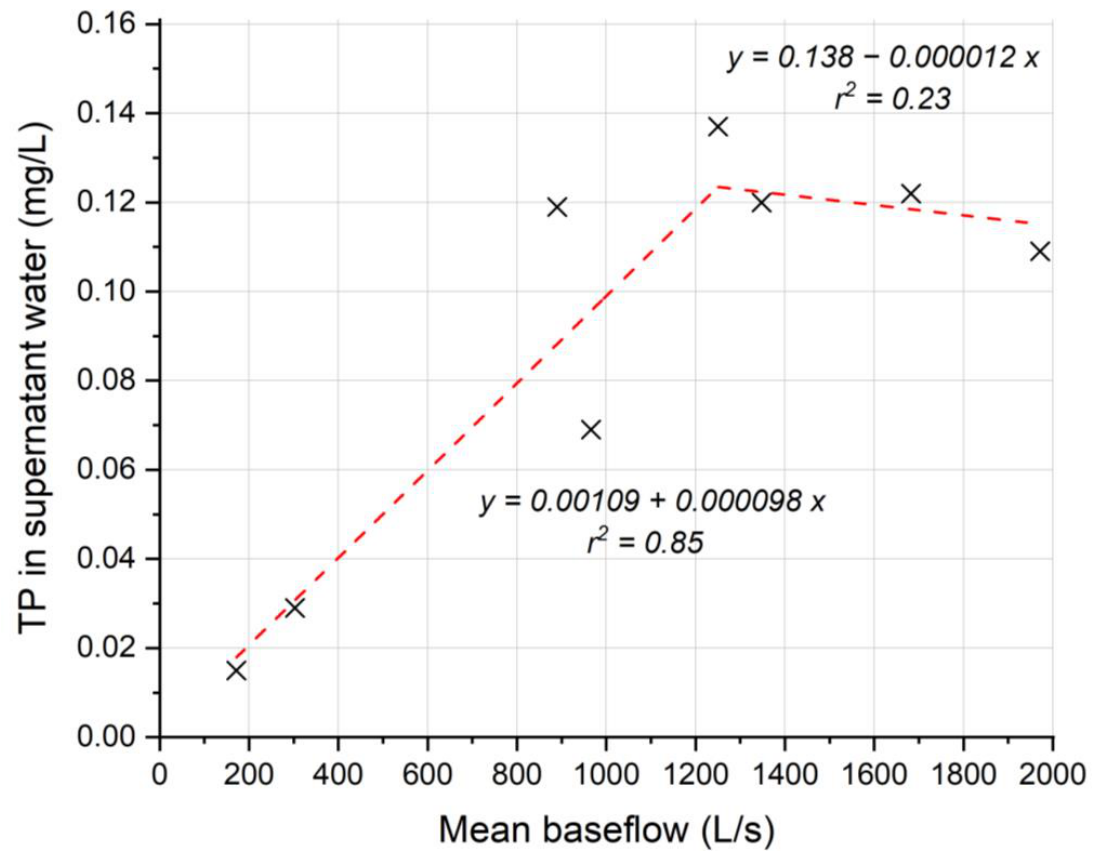
Figure 10. Rating curve between mean baseflow and TP in supernatant water.